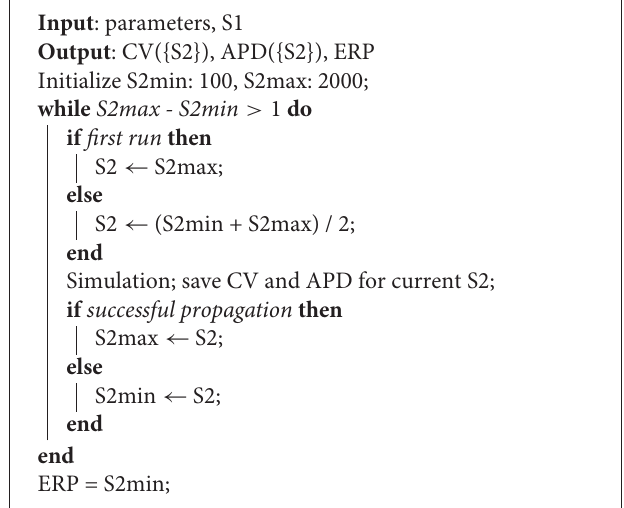
Algorithm 1: Strip simulation algorithm for S1S2 pacing. For a given S1 interval and set of model parameters, the simulation determines CV(S2) and APD(S2) restitution curves and